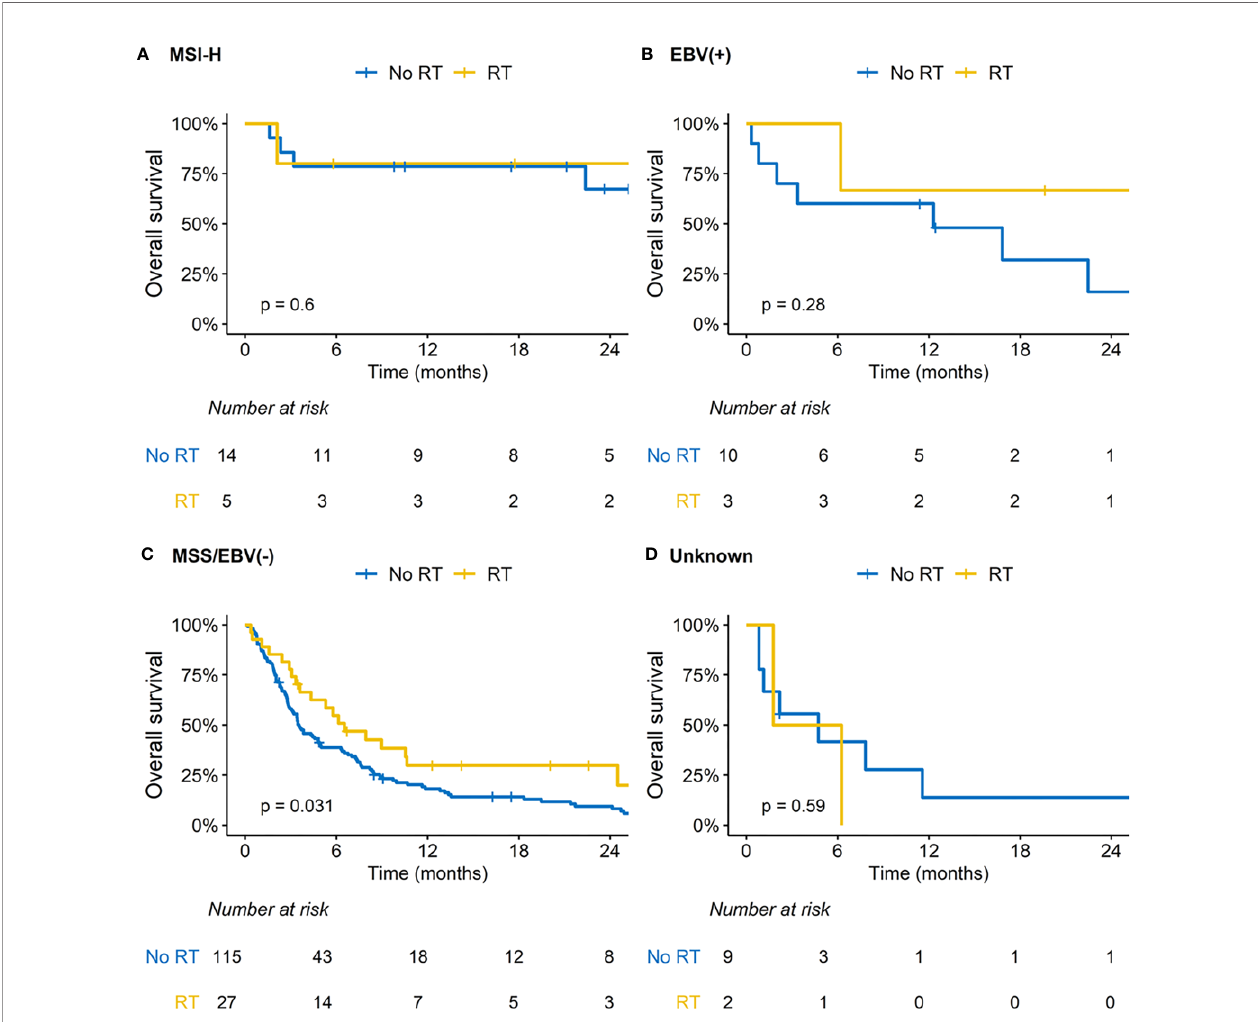
FIGURE 3 | Impact of radiation therapy (RT) on overall survival according to subgroups based on molecular category. (A) Microsatellite instability-high (MSI-H) tumor; (B) Ebstein-Barr virus (EBV) positive tumor; (C) Microsatellite stable (MSS)/EBV negative tumor; (D)